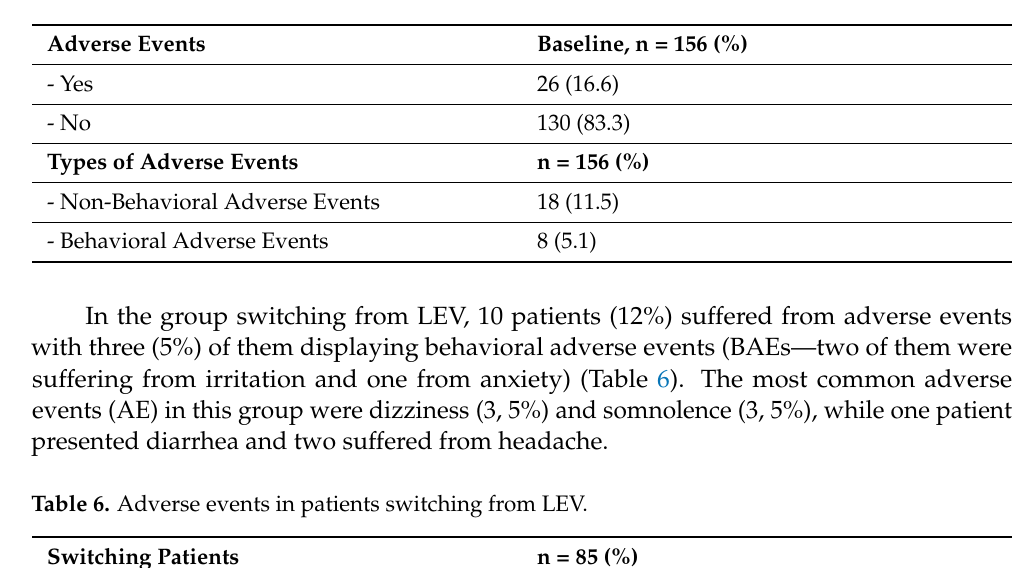
Figure 4. Response rates after BRV treatment correlated to BRV dose. Table 5. Adverse events.